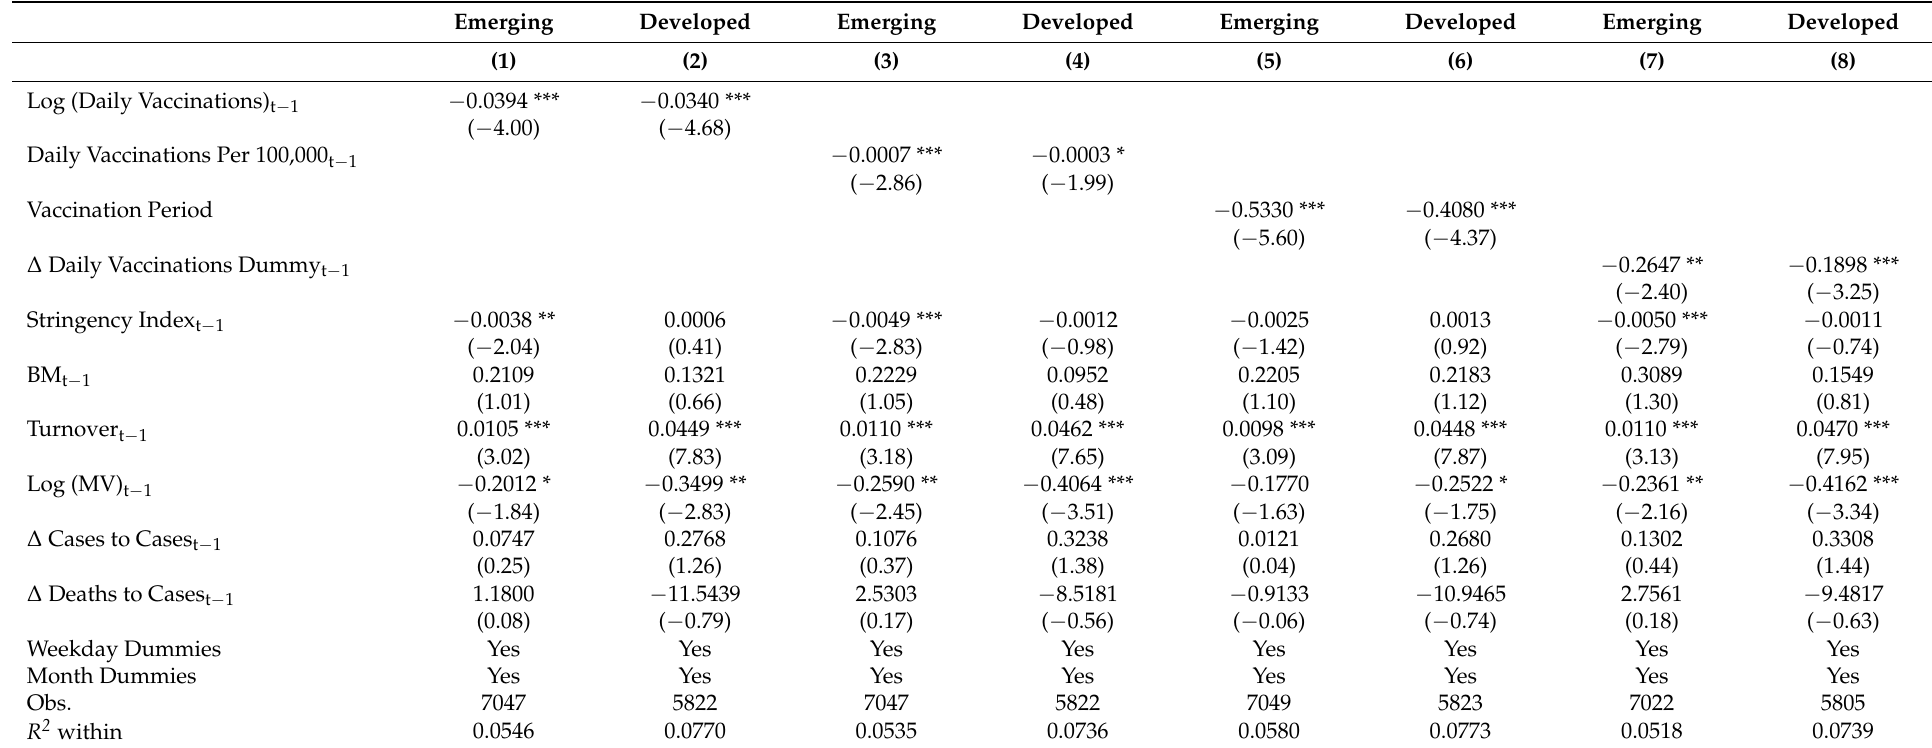
Table 7. The vaccination effect in developed and emerging